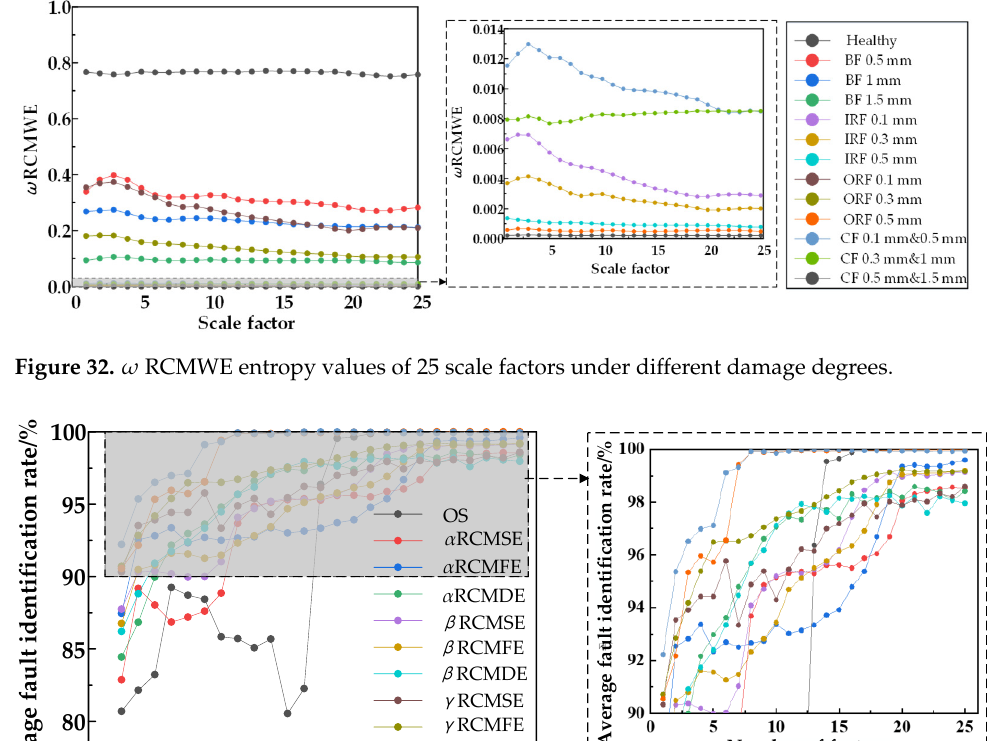
Figure 31. γ RCMDE entropy values of 25 scale factors under different damage degrees.